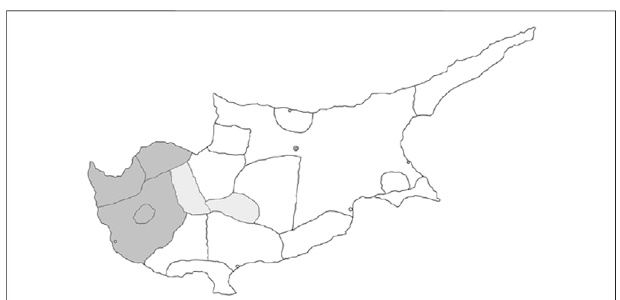
FIGURE5| SpecialintonationcontourinCyprus.Source:mapdesigned by Christodoulou (2015, 45) with data from Bagiakakos (1973). Reproduced with the permission of Charalambos